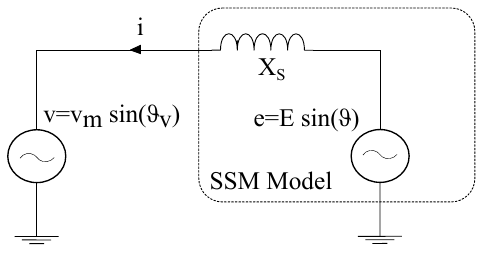
Figure 3. Model of an SSM connected to the